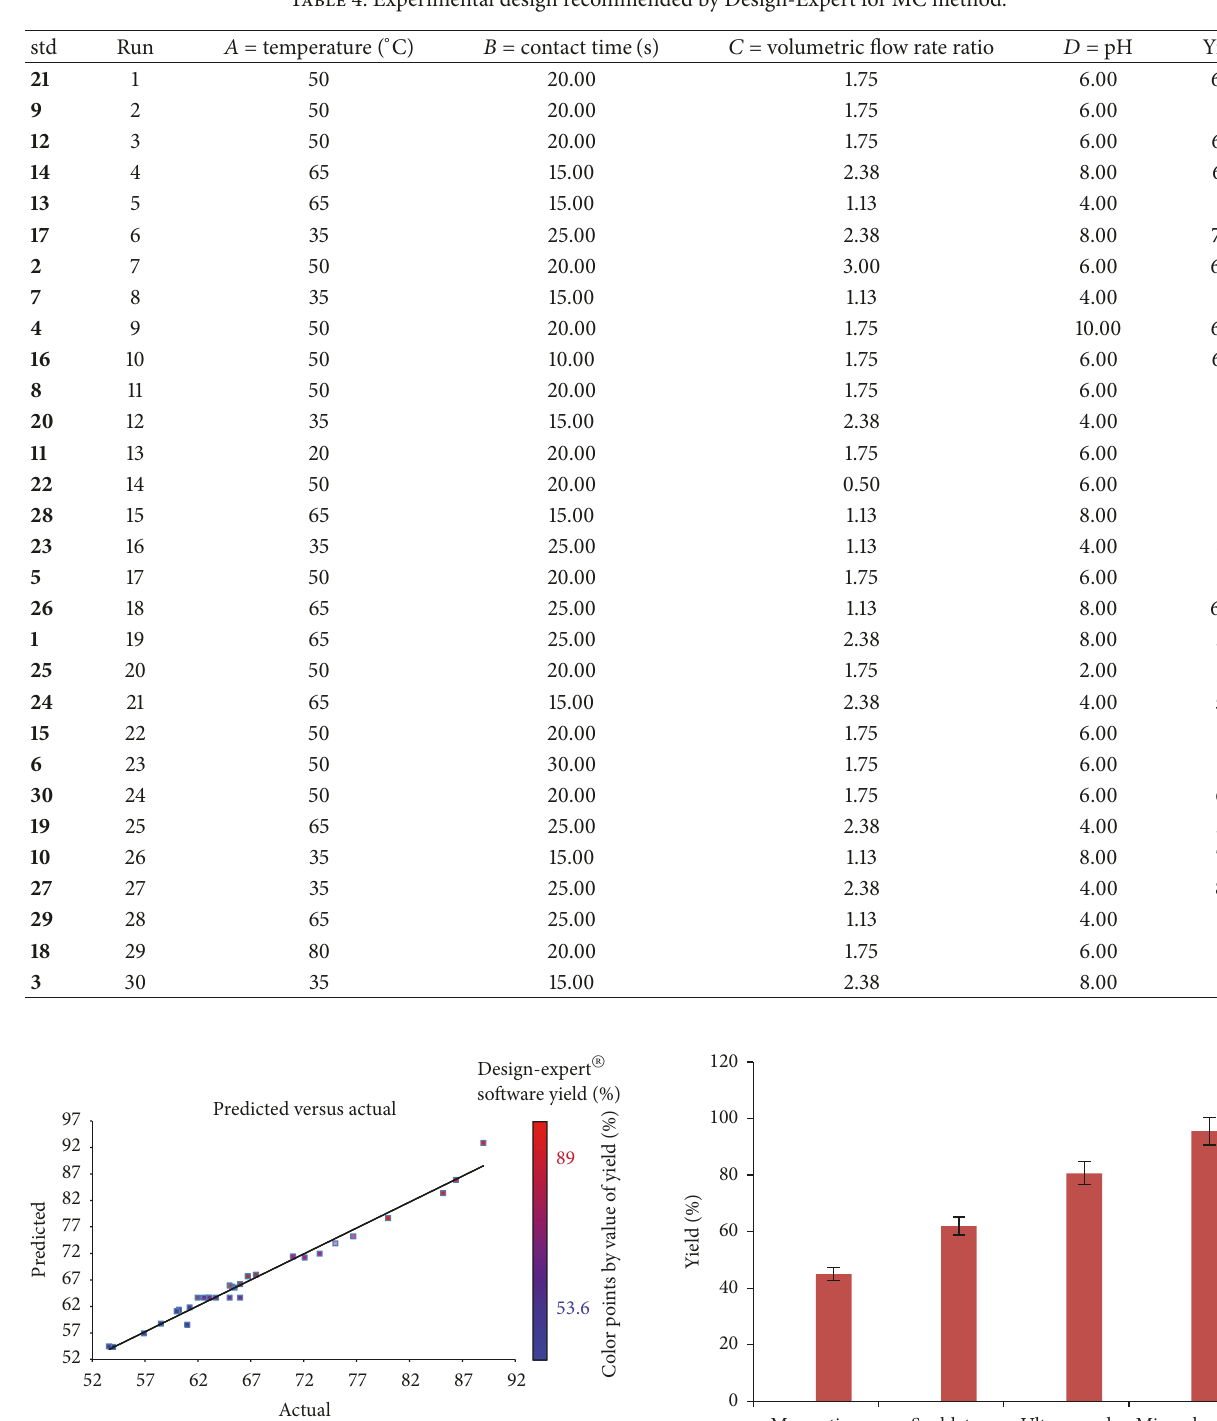
Table 4: Experimental design recommended by Design-Expert for MC method.